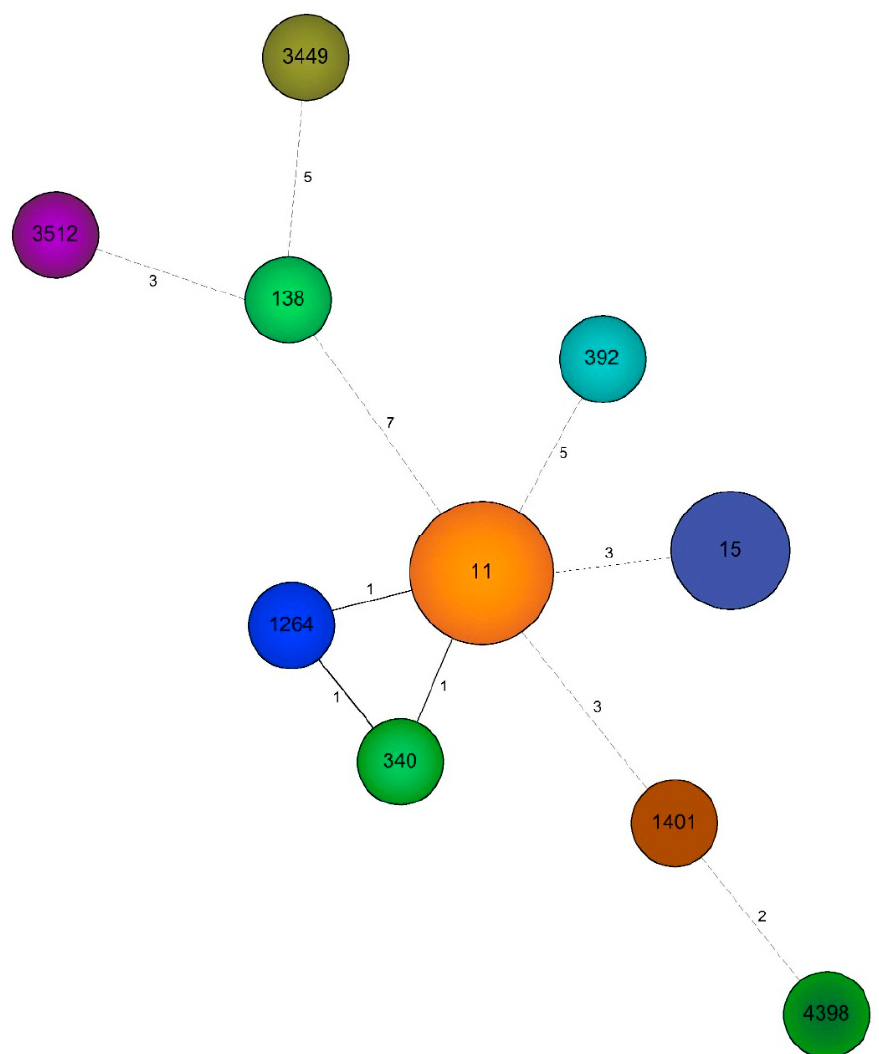
Figure 1. Minimum spanning tree (MST) of the 23 NDM-producing K. pneumoniae isolates genotyped by MLST. Each circle represents a different ST, and the size of the circle is proportional to the number of isolates related to the respective ST. The number next to the lines represents the number of loci variations between STs.